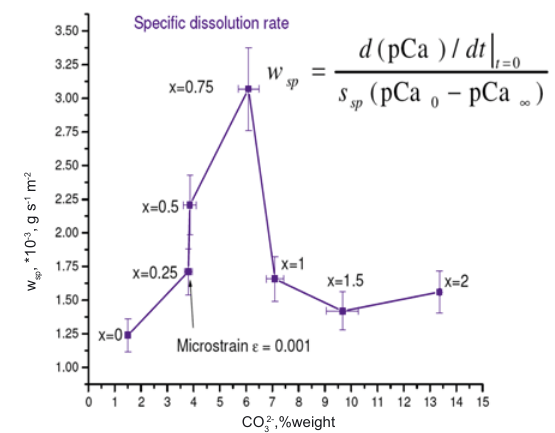
Figure 6. Dissolution rate of CHA in acetate buffer solution.